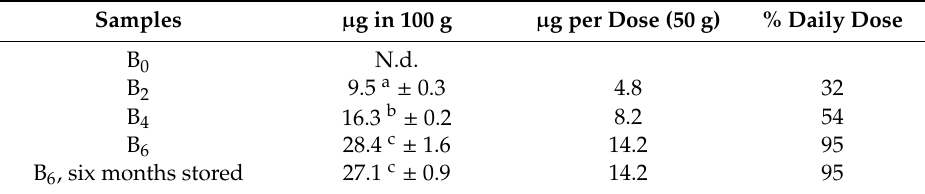
Table 2. Vitamin D 2 content of breadsticks enriched with Pleurotus ostreatus